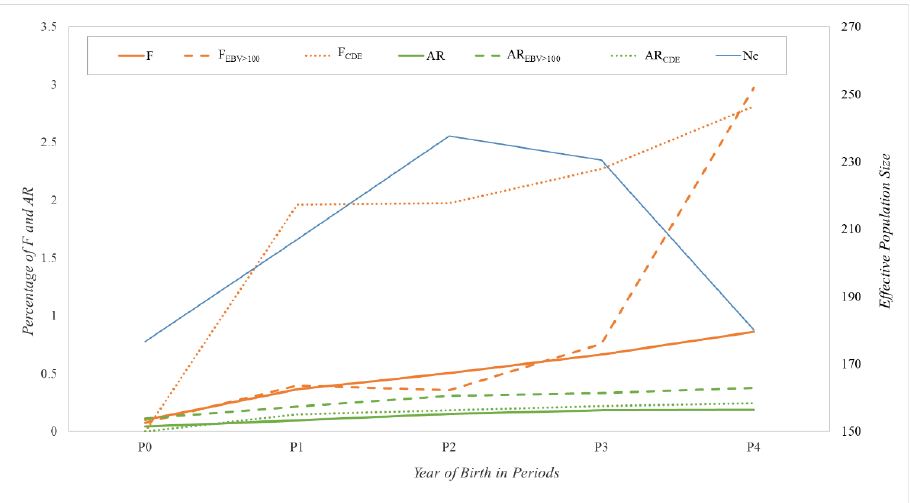
Figure 2. Evolution of average global inbreeding coefficient ( F ; orange solid line), for animals with breeding value over the mean for Show Jumping discipline ( F EBV>100 ; orange dashed line) and for animals with both parents from CDE ( F CDE ; orange dotted line). Evolution of average global relatedness coefficient ( AR ; green solid line), for animals with breeding value over the mean for Show Jumping discipline or ( AR EBV>100 ; green dashed line) and for animals with both parents from CDE ( AR CDE ; green dotted line). All values are in percentage. Evolution of effective population size computed via individual increase in inbreeding was also included ( Ne ; blue solid line). Where P0 is the period with animals born before 2000, P1 between 2000 and 2004, P2 between 2005 and 2009, P3 between 2010 and 2014, and P4 after 2015.